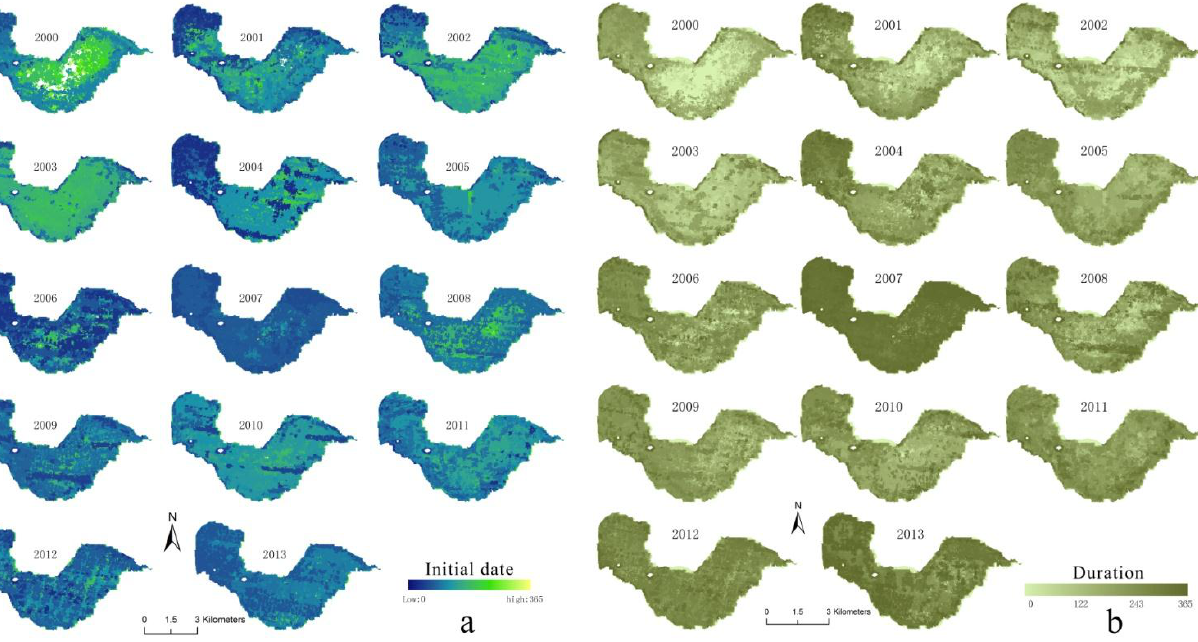
Figure 4. ( a ) Initial date of floating algae blooms in Lake Chaohu = Julian day when the bloom algae area exceeded 25% of the total surface area of the lake. ( b ) Duration of floating algae blooms in Lake Chaohu, defined as the difference between the last day and the initial day when blooms were identified (coverage > 0) using the algal bloom pixel growing algorithm (APA) and MODIS